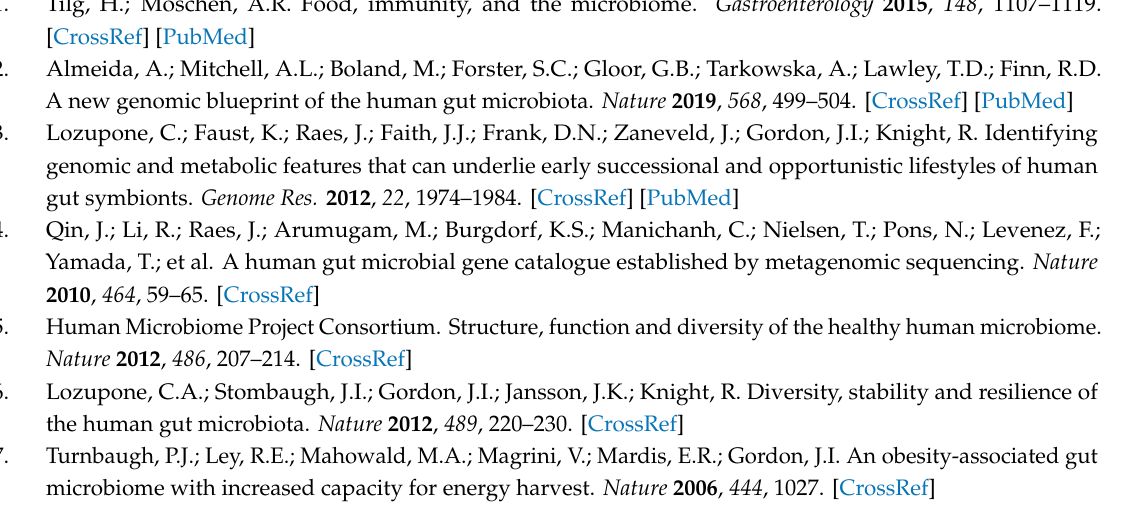
Table S1: Primer Sequences, Table S2: Baseline laboratory test results and medical data, Table S3: Intestinal well-being and symptoms during this study, Table S4: Comorbidities in study participants, Table S5: Lifestyle factors in study participants, Table S6: Shift values of reference peaks used for manual assignment of peak identities in NMR data, Figure S1: Baseline eating habits by gender, Figure S2: Results of V1–V3 region 16S sequencing, Figure S3: Individual trajectories of microbiota reconstitution V3–V4, Figure S4: Individual trajectories of microbiota reconstitution V1–V3, Figure S5: Di ff erentially abundant OTUs in the V1–V3 dataset and their mapping on the genus level, and Figure S6: Targeted analysis of NMR spectra for levels of PHGG and its associated metabolites galactose and